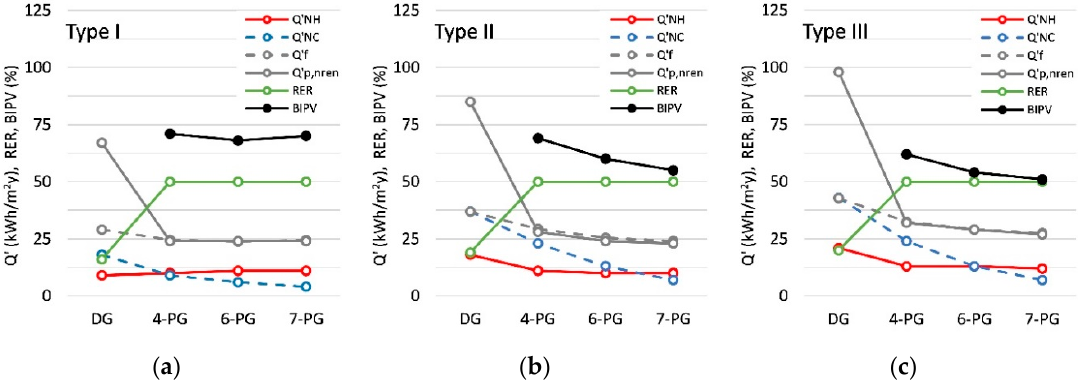
Figure 8. Energy efficiency and nZEB indicators for the buildings constructed with advanced glazed and BIPV facade structures in Type I ( a ), Type II ( b ), and Type III ( c ) buildings in Zurich; note that the area of PV cells in the BIPV glassed facade structure is 60% of the total facade structure